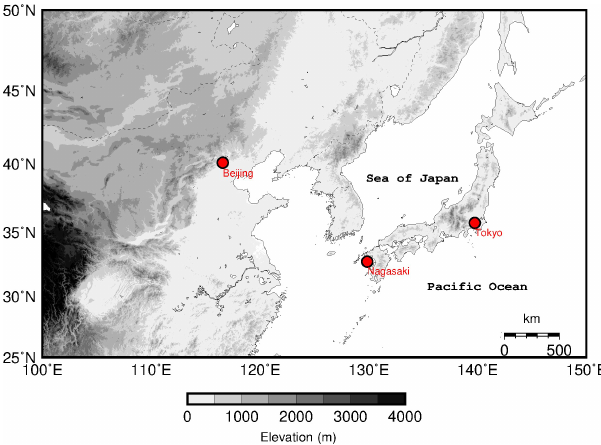
Figure 4. Locations of the early instrumental surface pressure data records used in this